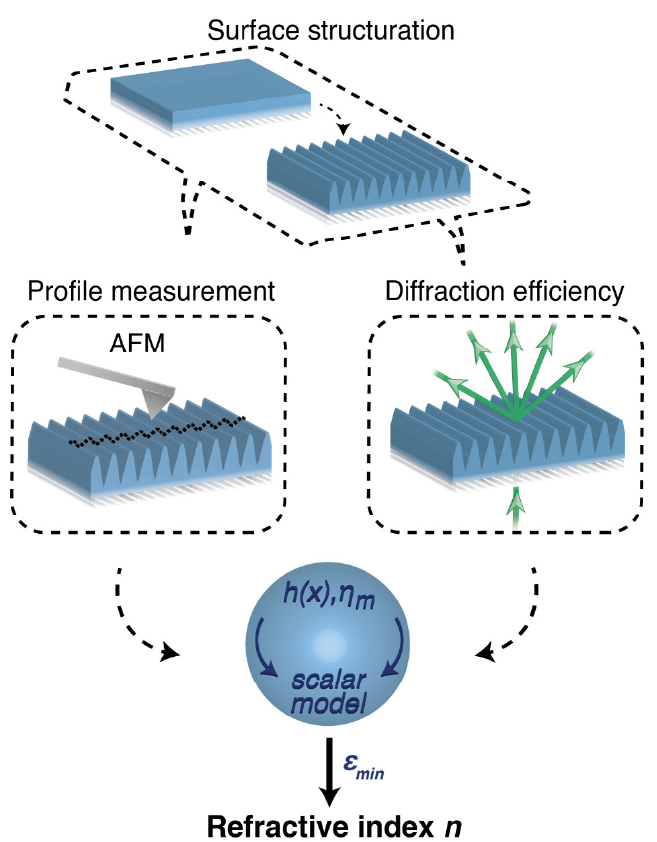
Figure 2. Workflow of the method. The diffractive refractometer based on the scalar theory involves structuring the material with a surface grating profile whose geometry satisfies the scalar approxima- tion. The actual surface profile of the grating and the relative diffraction efficiency are measured and compared with the scalar diffraction model to estimate the best fit of n